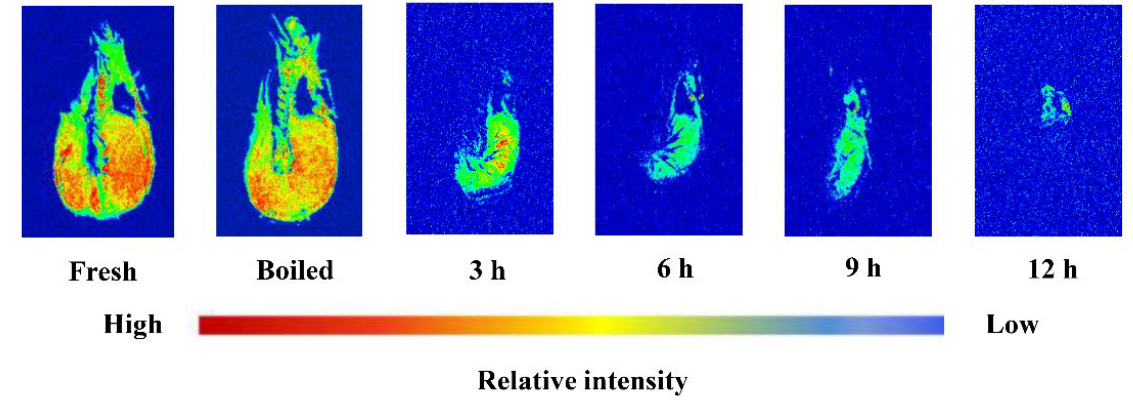
Figure 4. T 2 weighted MRI images of shrimp dried by hot air drying at different levels .